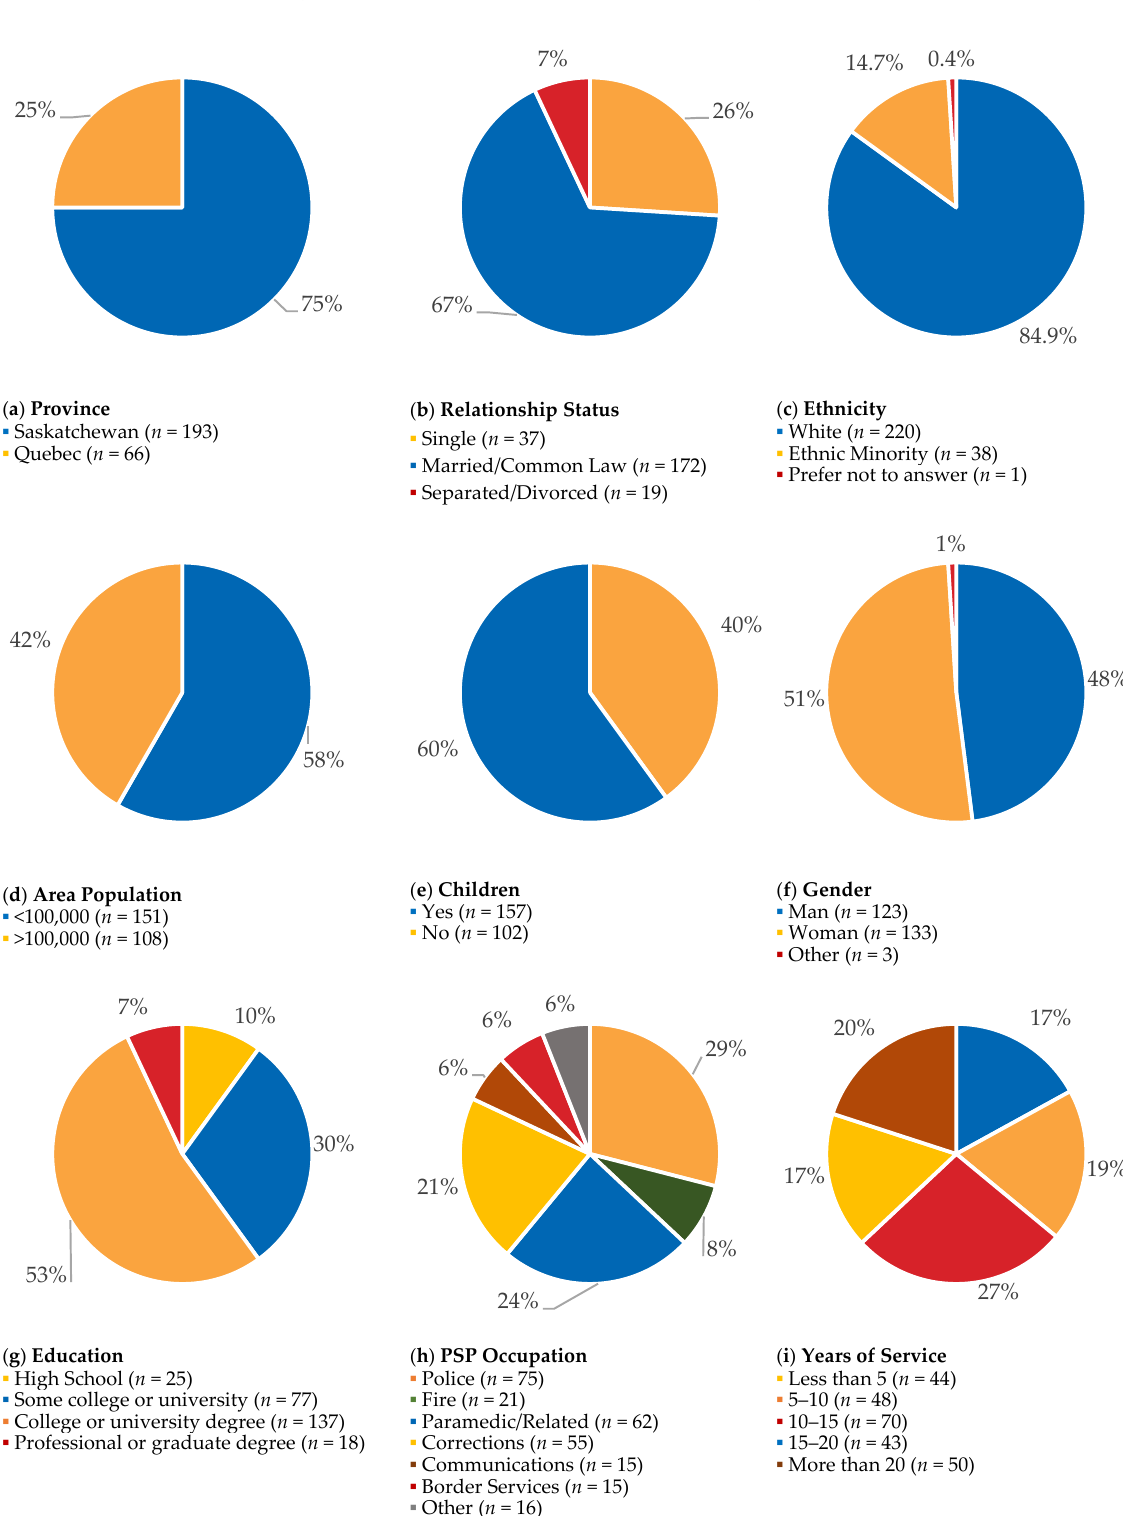
Figure 1. Participant demographic